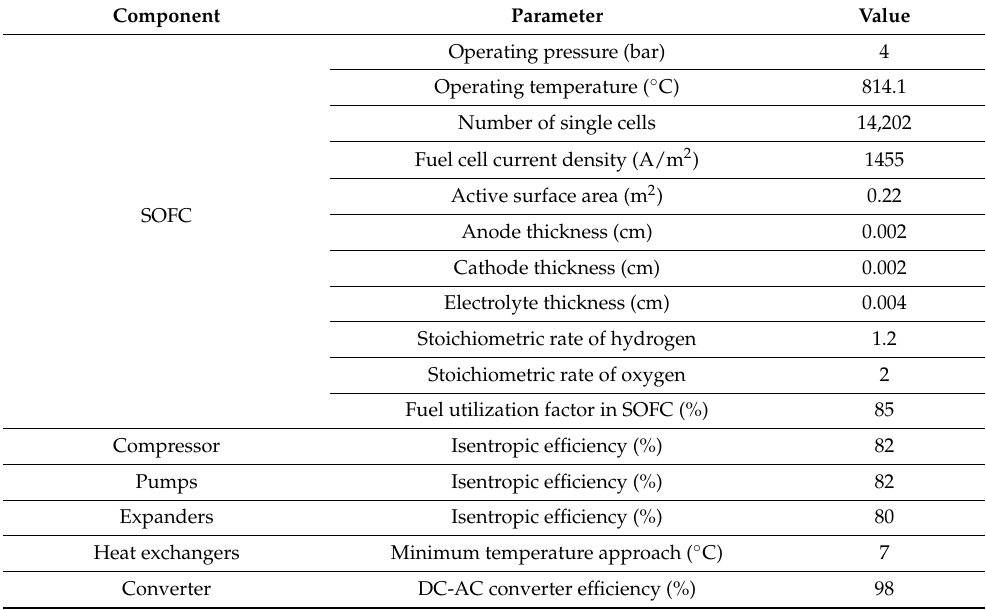
Table 1. Boundary conditions of the proposed